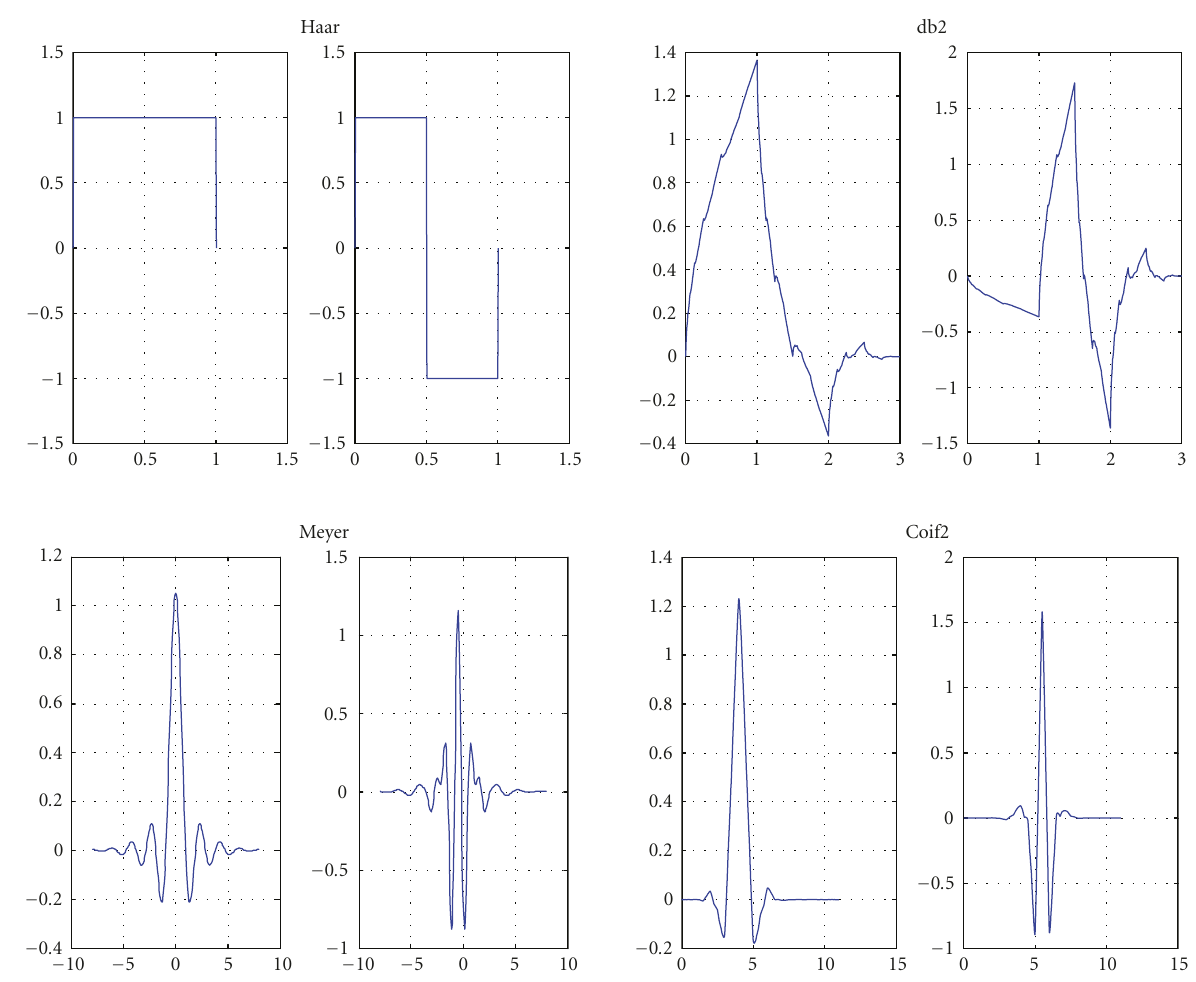
Figure 15: Some popular wavelet functions and respective scaling